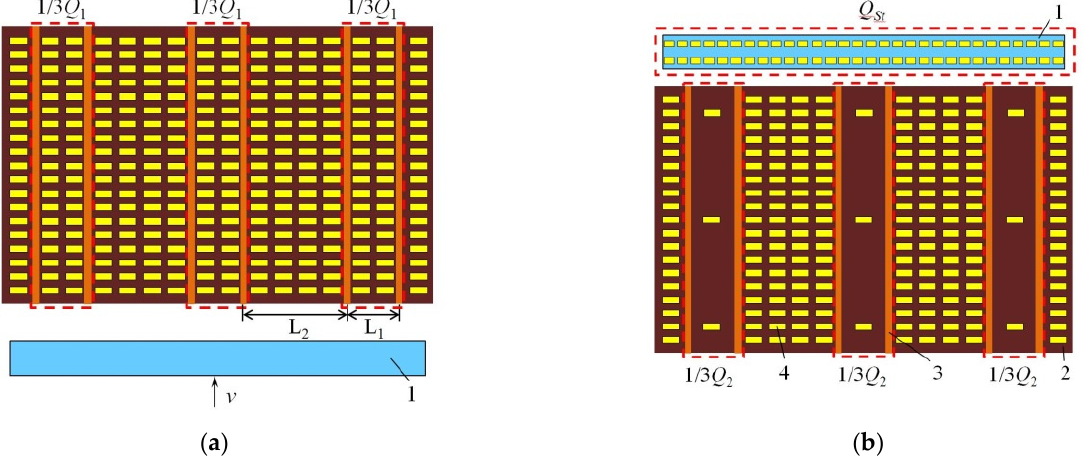
Figure 3. Mathematical model of the relationship between the SFA and the SMQ. ( a ) Theoretical model before no-tillage operation; ( b ) theoretical model after a no-tillage operation. Note: 1, the hopper of SDM; 2, no-tillage surface of the field; 3, seed line; 4, straw residue. Q 1 is the mass of straw on the sowing strip before an operation, kg; Q 2 is the residual mass of straw on the sowing strip after an operation, kg; Q St is the total mass of straw fed into the hopper after a certain period of operation, kg; v is the OVM, km/h; L 1 is the total cleaning width of sowing strip, mm; L 2 is the total width of non-sowing area, mm.